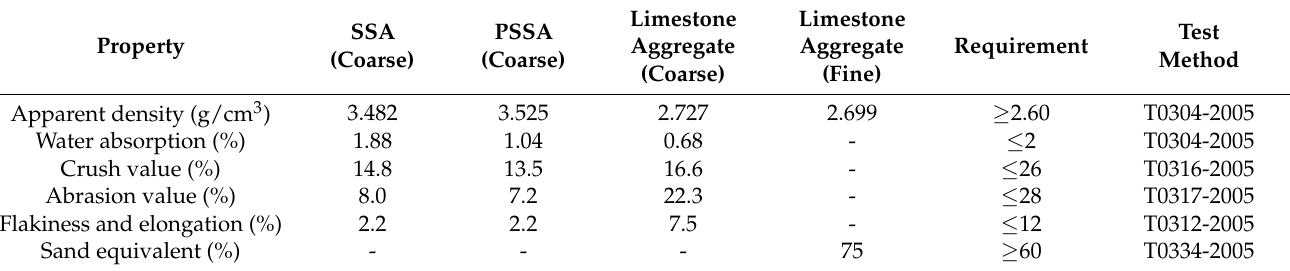
Table 2. Specifications of SSA, PSSA and limestone